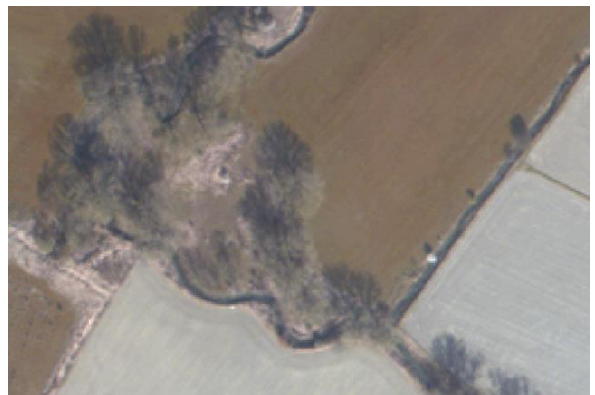
Figure 6. Portion of the image before